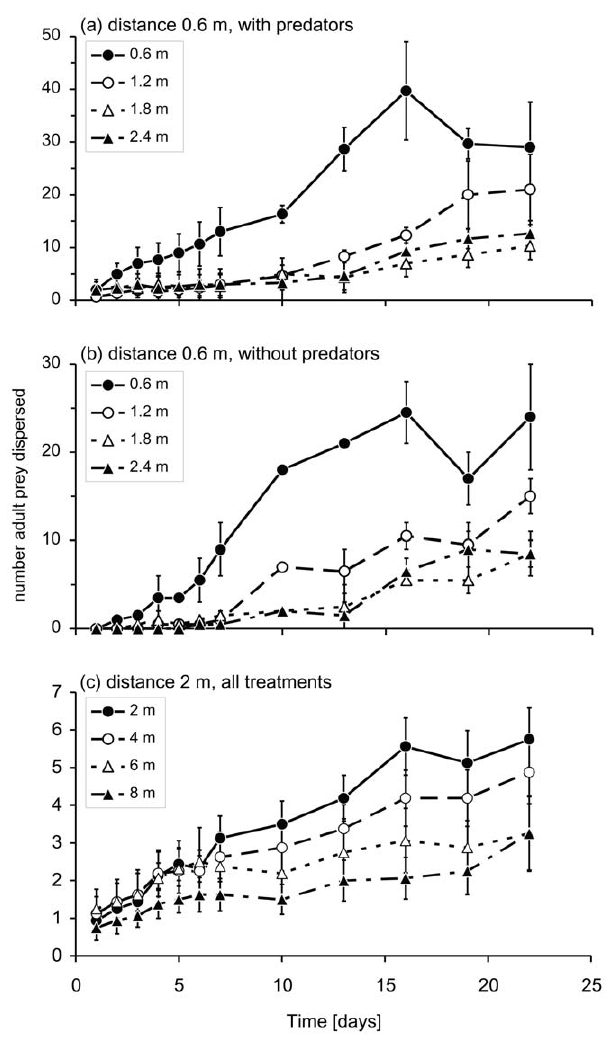
Figure 3. The average ( 6 s.e.m.) numbers of adult whiteflies that dispersed to plants at various distances from the plant on which they were released as a function of time since release. (a) Distance between neighbouring plants 0.6 m, treatment with predators on the release plant. (b) Distance 0.6 m, treatment without predators. Significantly more prey were recaptured through time on the plant at 0.6 m. The two treatments are shown separately to demonstrate the absence of an interaction of treatment with the distance dispersed. (c) Distance between neighbouring plants 2 m. The numbers of prey recaptured did not differ significantly among plants.